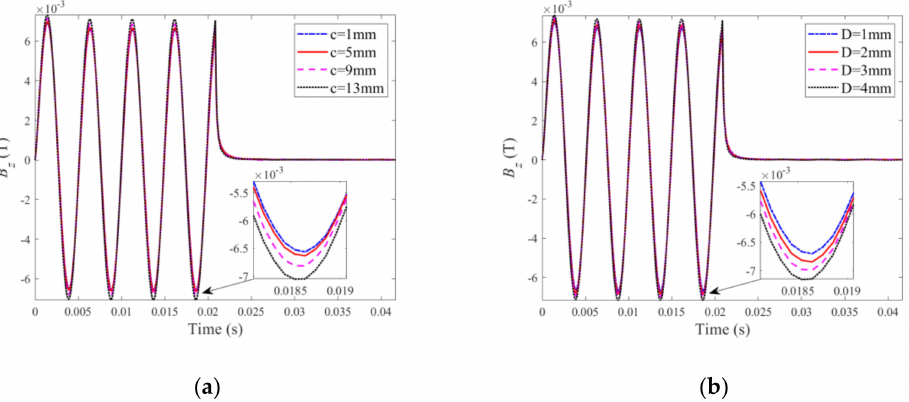
Figure 4. Testing signals predicted by the semi-analytical model: ( a ) ILCs with various radii; ( b ) ILCs with various